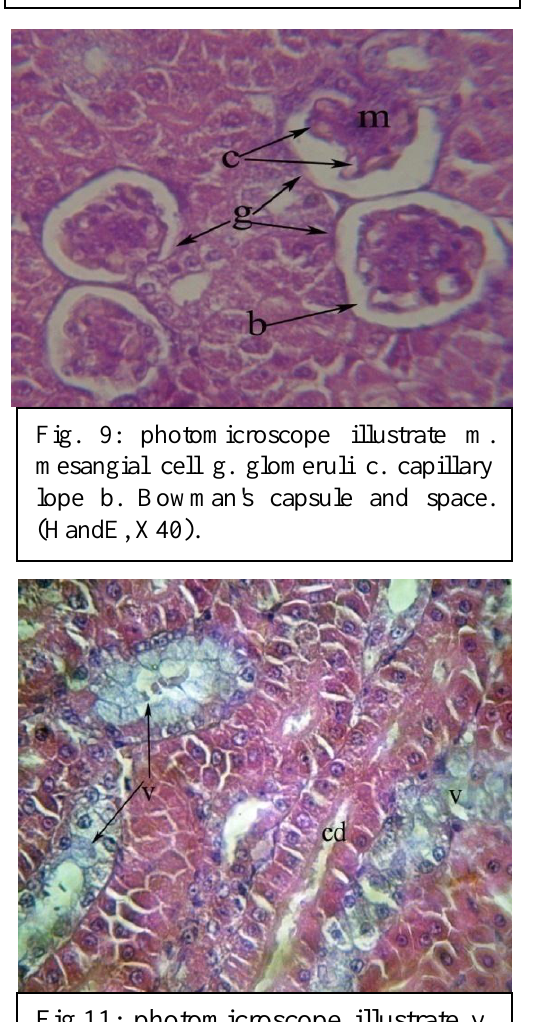
Fig.11: photomicroscope illustrate v. vacuoles in side cd. collecting ducts .(H and E, X40).